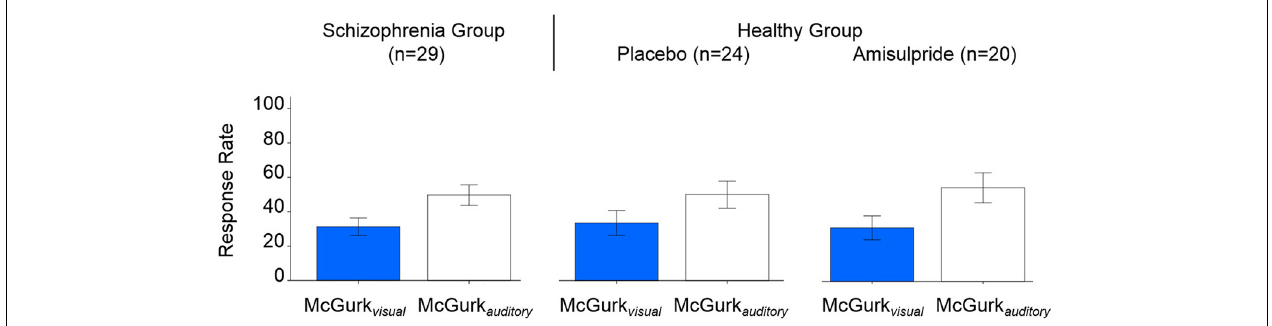
FIGURE 3 | Group-averaged McGurk visual and McGurk auditory rates, for the schizophrenia group (left), and the healthy group after placebo (center) and after amisulpride (right). Blue bars show McGurk visual rates, white bars show McGurk auditory rates. Error bars signify the standard errors of the mean.